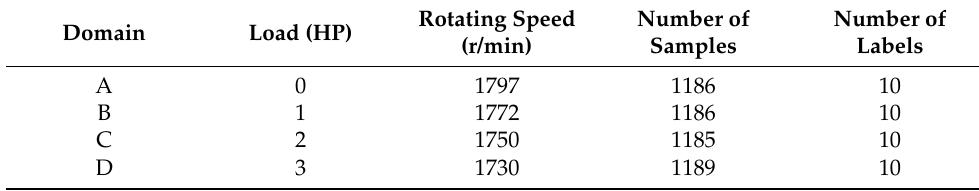
Table 2. Description of the CWRU dataset.